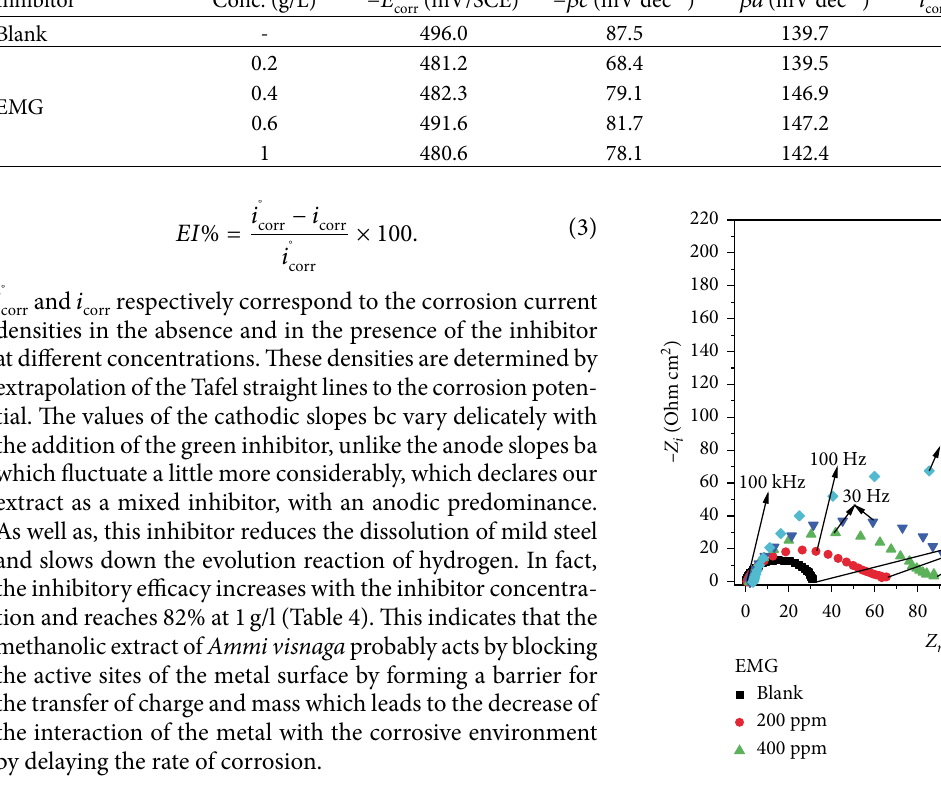
Figure 6: Nyquist diagrams of steel in 1 M HCl without and in the presence of different concentrations of EMG.